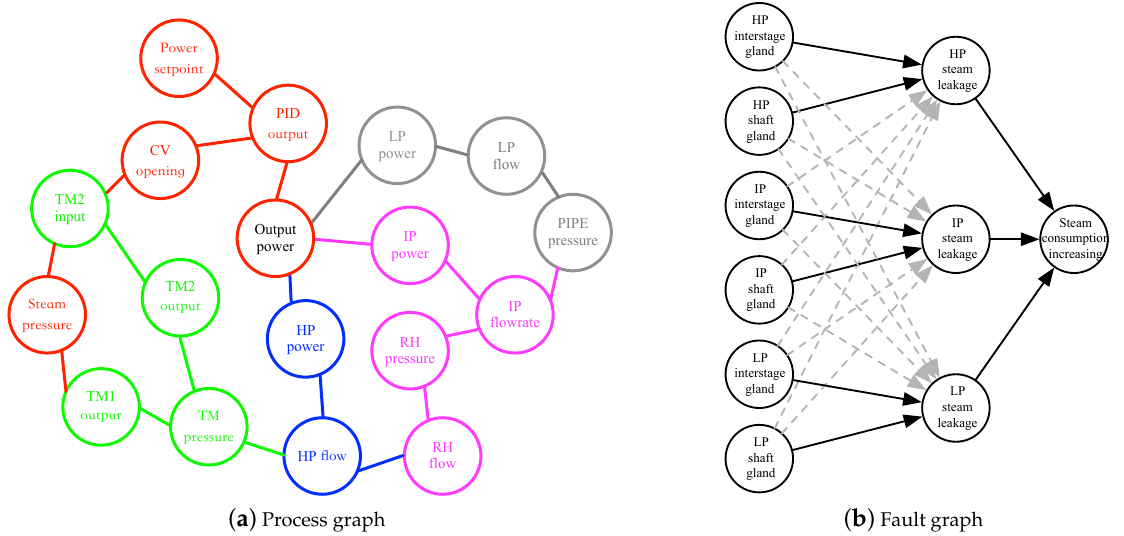
Figure 3. Process graph and fault propagation graph for steam turbine systems.The process graph contains 18 physical variables of steam turbine, and different colored nodes and edges represent different relationships. There are three layers in the fault graph, which respectively show the gland fault, the steam leakage and the steam consumption rate